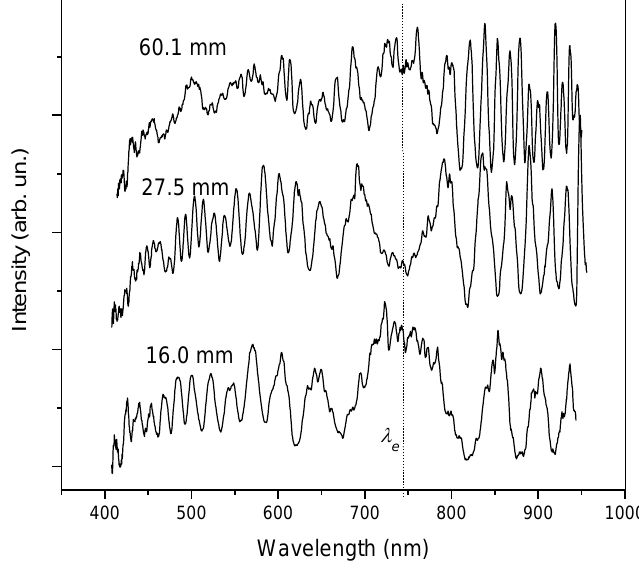
Figure 3. Interference signal for LCOF filled with pure silicon oil measured for different LCOF